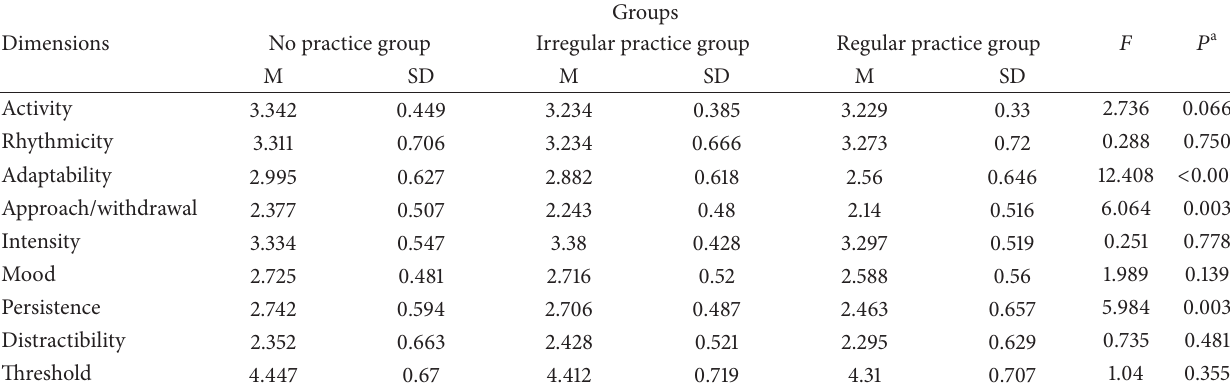
Table 5: The comparison of nine dimensions of infant temperament among the three groups ( 𝑁 = 302 ).